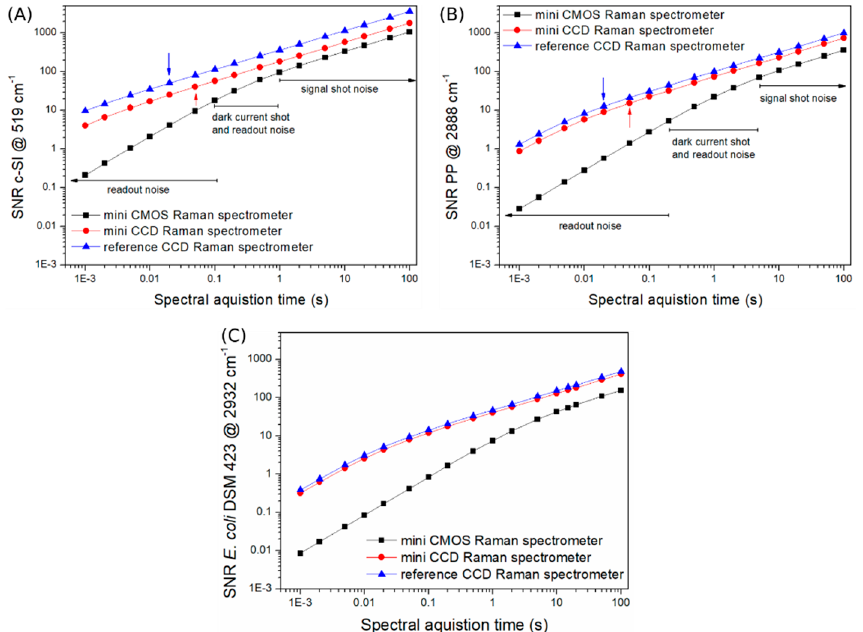
Figure 3. Spectral acquisition time dependent SNR on double logarithmic scale for selected Raman marker bands of ( A ) c-Si, ( B ) PP and ( C ) E. coli DSM 423 theoretically calculated for the three spectrometers. In ( A , B ) the time domains where different noise sources dominate are indicated: mini CMOS Raman spectrometer with three domains, mini and reference CCD Raman spectrometers with two domains indicated by arrows. In ( C ) four noise sources compete. The delimitation of time domains is complex.